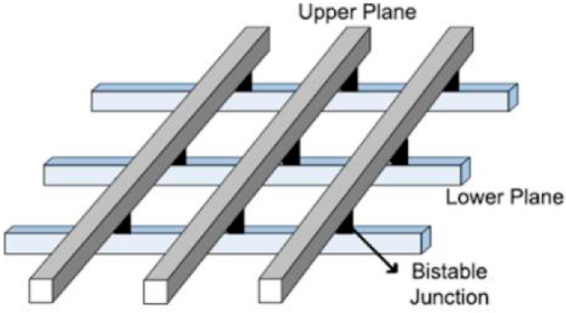
Figure 1. Schematic representation of a nanocrossbar (NC) architecture.